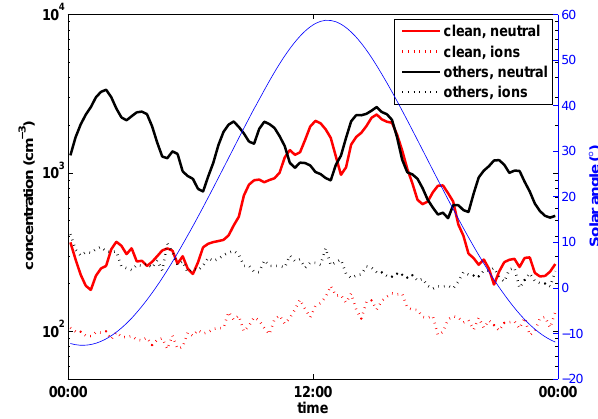
Fig. 4. Diurnal variation of nano-CN and 1.5–3nm ions (pos+neg) in Mace Head. The data is divided into two fractions depending on whether the air mass trajectories came directly from the ocean (clean, red lines), or if they had passed over land areas (others, black lines). The blue line represents the calculated solar elevation angle in Mace Head during